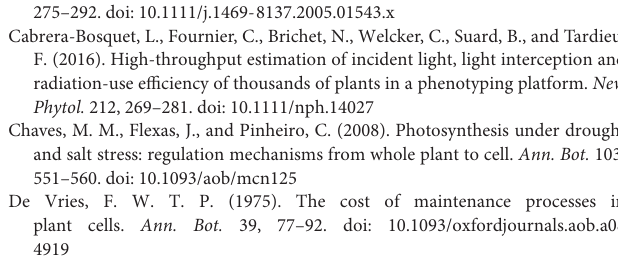
Supplementary Figure 1 | Ion contents in tissues of quinoa at different levels of salinity 77 DAS (41 days after the start of salt stress). (A) [Na + ] in different tissues of quinoa at different levels of salinity. (B) [Cl − ] in different tissues of quinoa at different levels of salinity. (C) [K + ] in different tissues of quinoa at different levels of salinity.Means of 4 plants. Error bars indicate SE of individual means. Statistically significant differences ( p ≤ 0.05) between any variety and salt treatment combination (within each tissue) are shown with different letters. Supplementary Table 1 | Timetable of the different measurements/treatments included in this study. Supplementary Table 2 | Comparison between gs measured with a porometer in the abaxial and the adaxial side of leaves of quinoa plants growing under